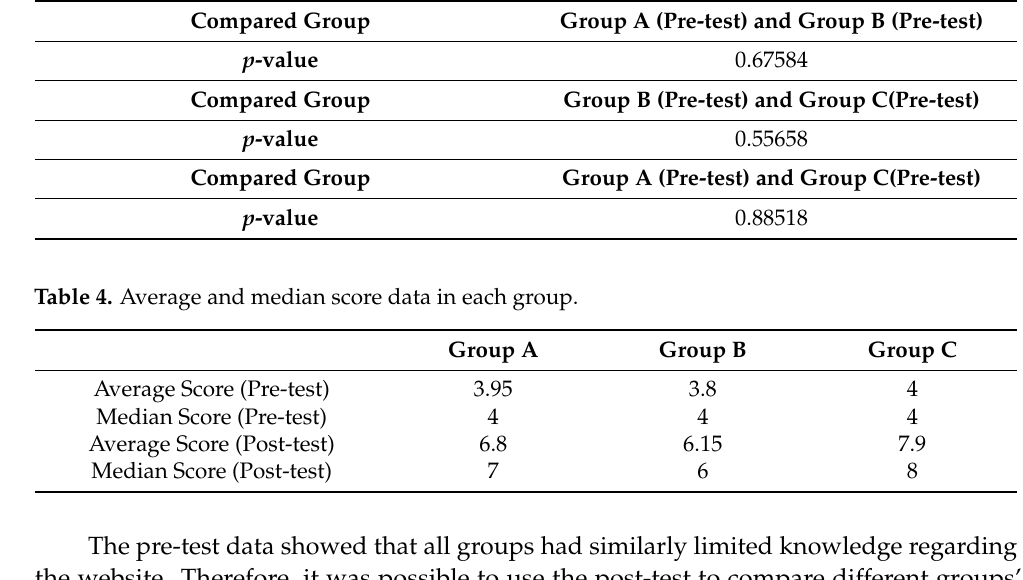
Table 3. p -value between different groups (pre-test) in Excel Software.